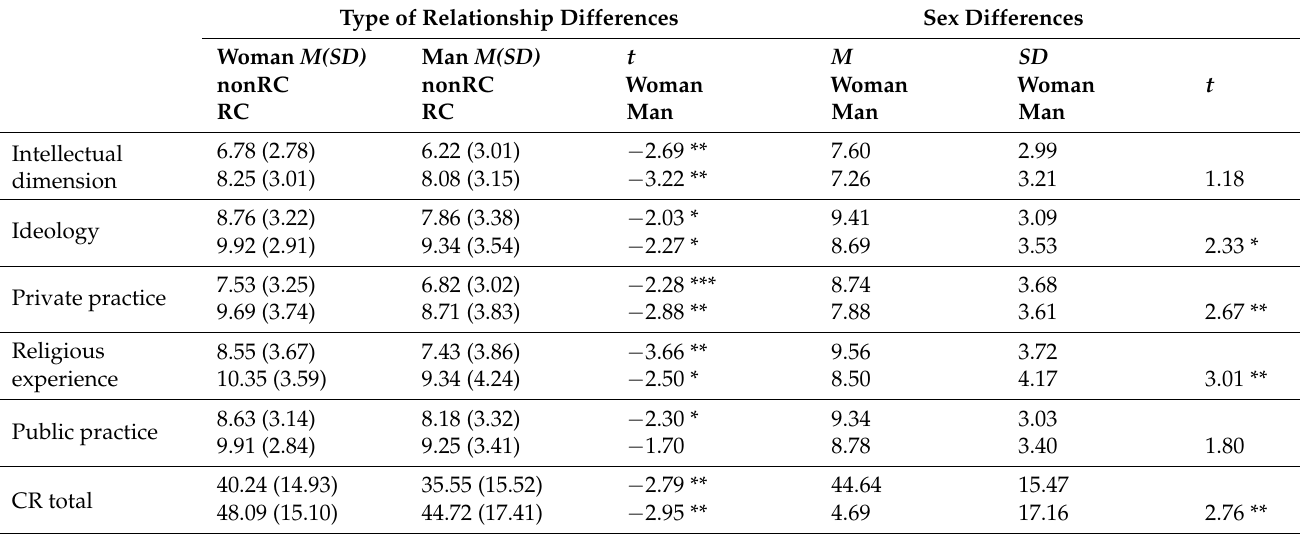
Table 1. Descriptive statistics, Cronbach’s α , and the sex and group differences (CRS). Type of Relationship Differences Sex